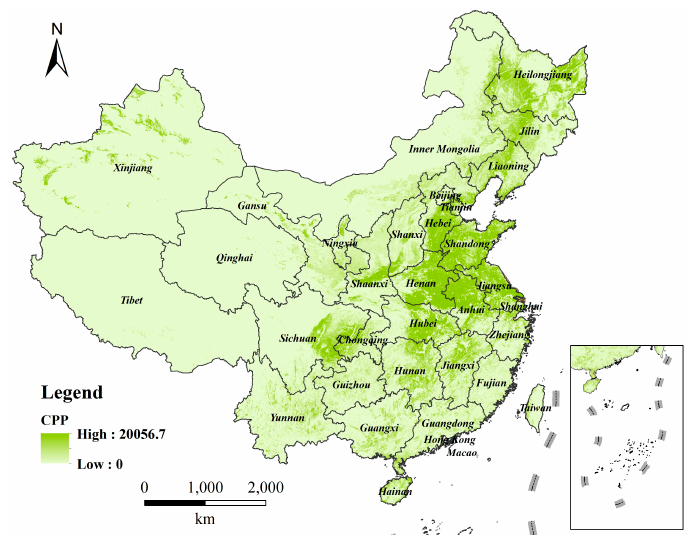
Figure 1. Spatial distribution map of CPP in China.